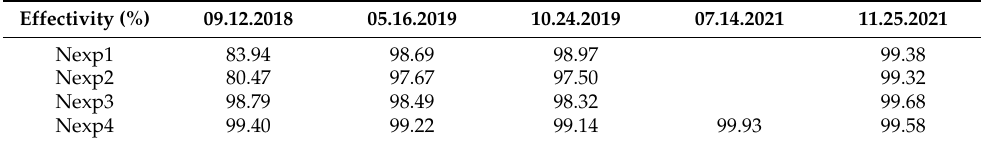
Table 9. DP-SACI effectivity (%) at control points during the